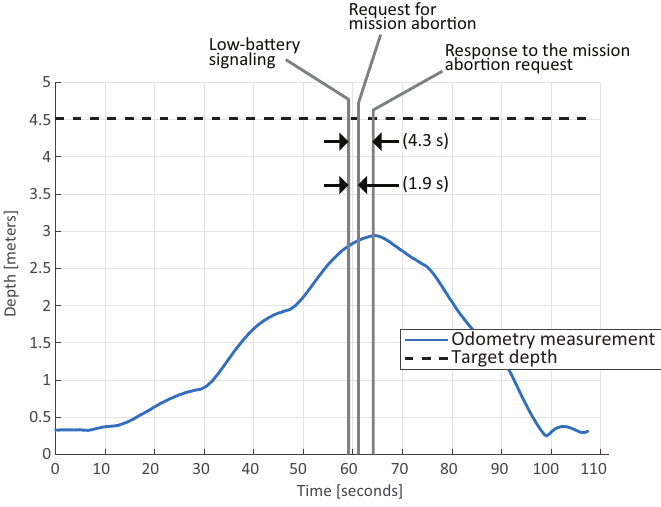
Figure 16. Event handling